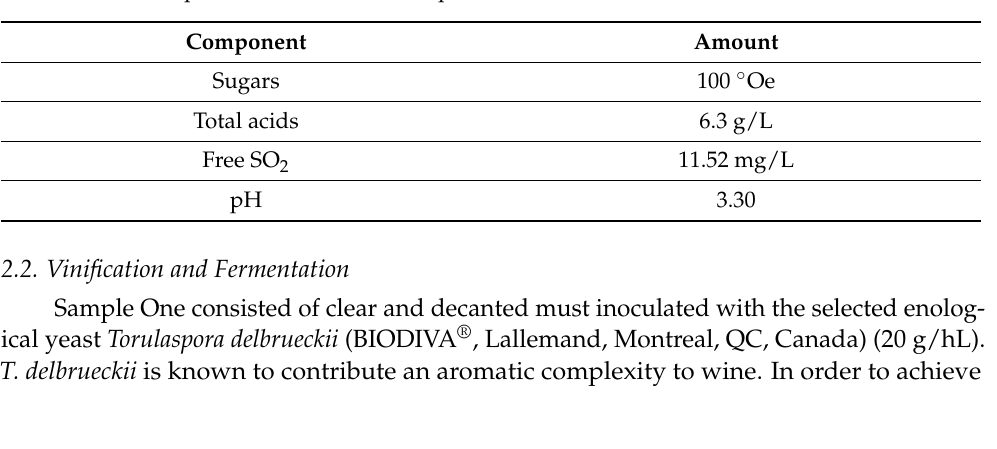
Table 1. Basic composition of clarified must prior to